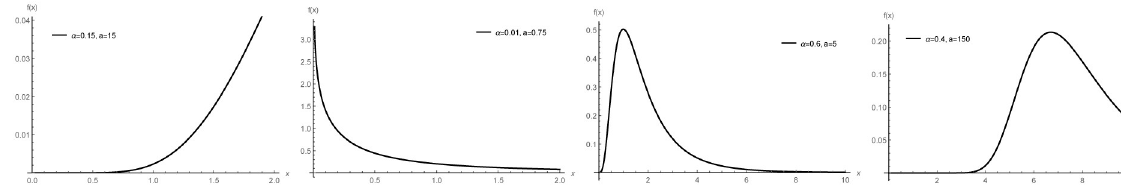
Fig 1. Plots of the PDFs of the WBHD.